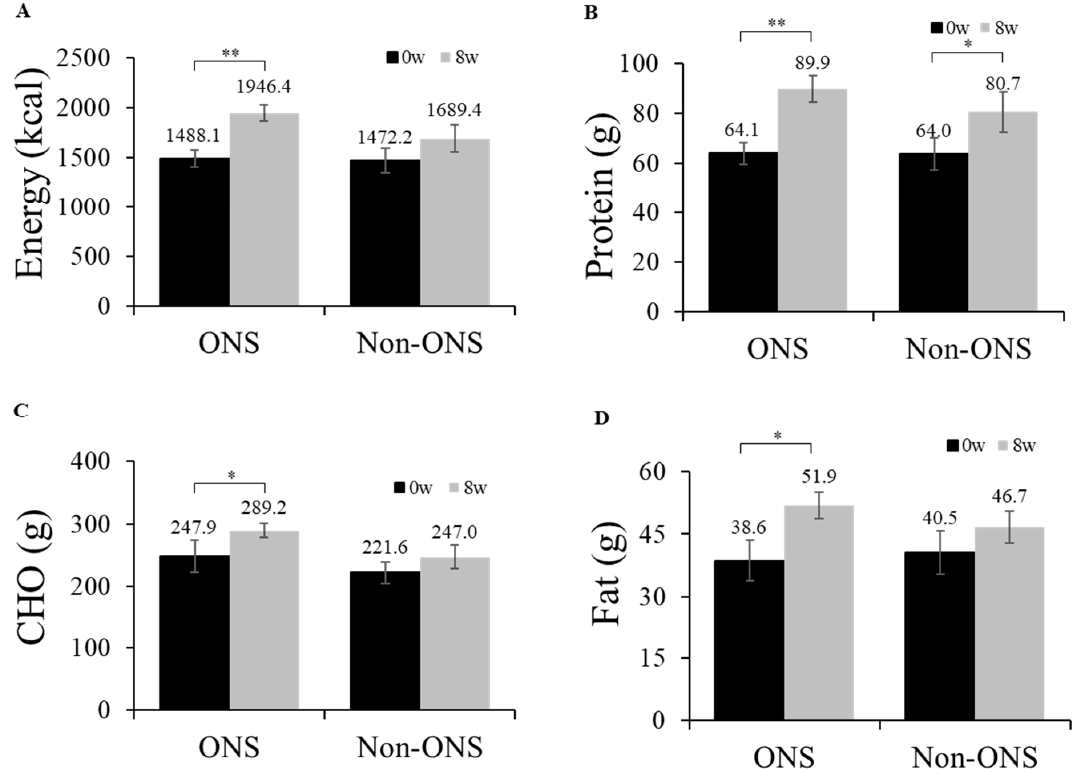
Figure 2. Daily oral intake at week 0 and week 8. Changes in energy intake ( A ), protein intake ( B ), carbohydrate intake ( C ), and fat intake ( D ) are shown. Values are mean ± SE. Significant di ff erences between the ONS group and non-ONS group were analyzed by the Mann–Whitney test. Significant di ff erences between 0 weeks (baseline) and 8 weeks were determined by the Wilcoxon signed rank test. CHO carbohydrate, * p < 0.05; ** p < 0.01.